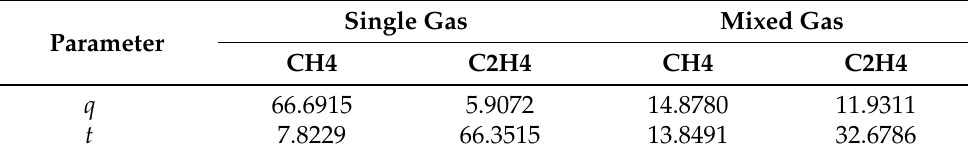
Table 6. The best parameter combination.